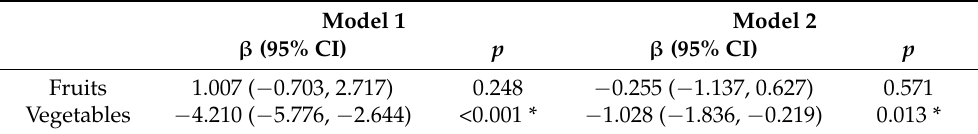
Model 1: Not adjusted; Model 2: Adjusted for demographic parameters, diabetes duration, anthropometric parameters, diabetes family history, lifestyle factors, food intake and biochemical index values (HbA1c, ALT, AST and serum lipid levels). * The β value and 95% CI was statistical significance ( p <